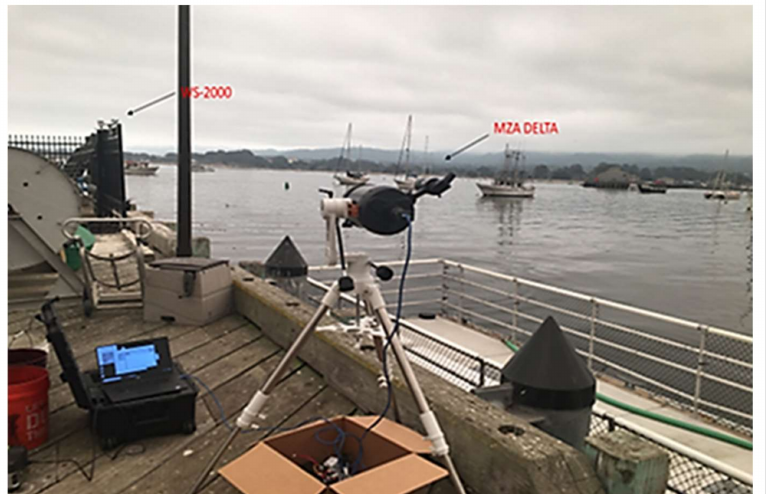
Figure 2. The laser propagation path over Monterey Bay, CA. The MZA DELTA transmitter is located on the Coast Guard Pier (upper left) and the target board is on a coastal